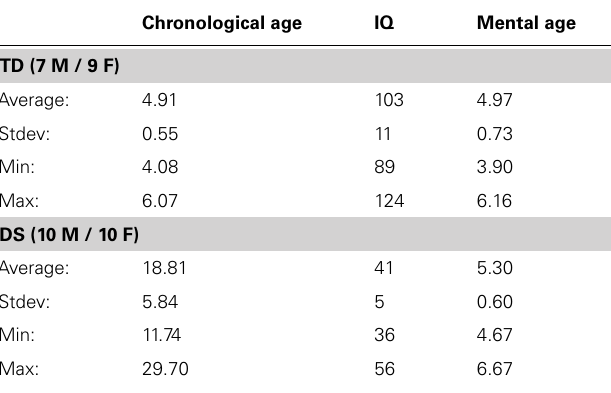
Table 1 | Demographics of the two groups of participants tested in this